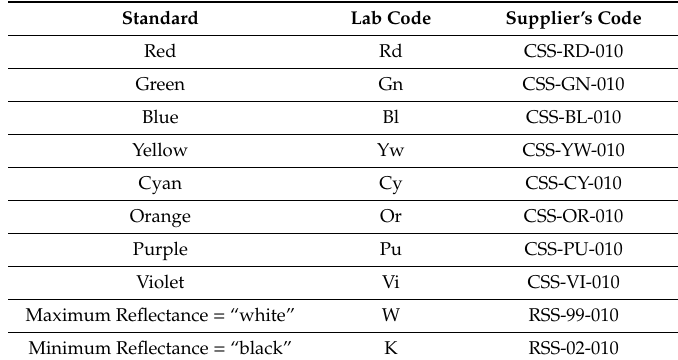
Table 1. Description of standard samples listed according to the hue, the laboratory code (Lab Code), and the code provided by the supplier. The standards having minimum (2%) and maximum (99%) reflectance were used, respectively, as black and white references. For each sample, the diameter was of 1.25 inches, except for the maximum and minimum targets, which were 1 inch.